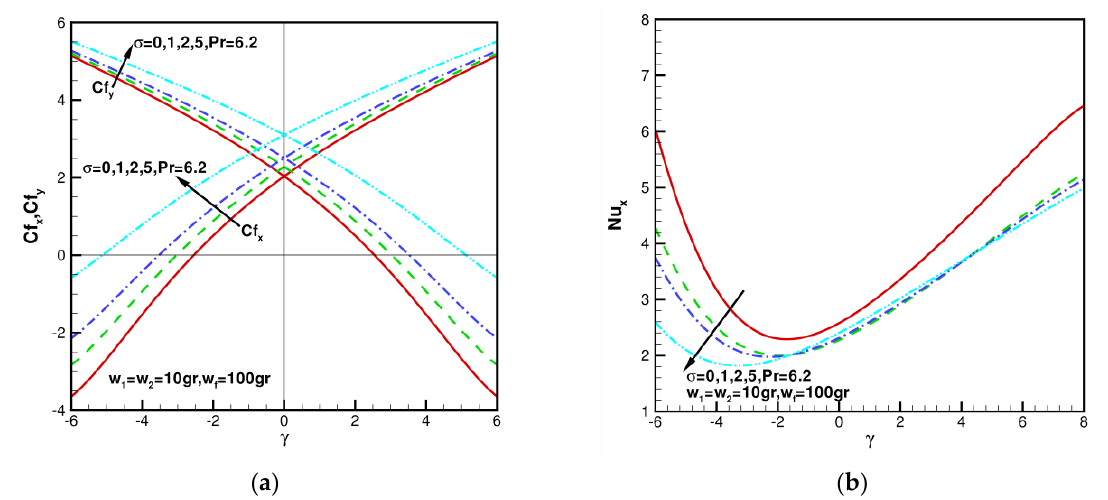
Figure 8. Skin friction coefficients Cf x , Cf y and local Nusselt number Nu x against γ when w 1 = w 2 = 10 gr, w f = 100 gr, σ = 0, 1, 2, 5, and Pr = 6.2: ( a ) the distribution of Cf x , Cf y with n 1 = n 2 = 3 (sphere); ( b ) the distribution of Nu x with n 1 = n 2 = 3 (sphere). When w 1 = 10 gr, w f = 100 gr, Pr = 6.2 n 1 = n 2 = 3 (spherical nanoparticles), skin friction coefficients of C f x , C f y with γ in the range of − 6 ≤ γ ≤ 6 for various w 2 = 0, 10 gr, 30 gr, σ = 0, 1 are shown in Figure 9a. When w 1 = 10 gr, w f = 100 gr, σ = 0, C f x = C f y = 1.40293, 2.03443, 2.42377 for various w 2 = 0, 10 gr, 30 gr.